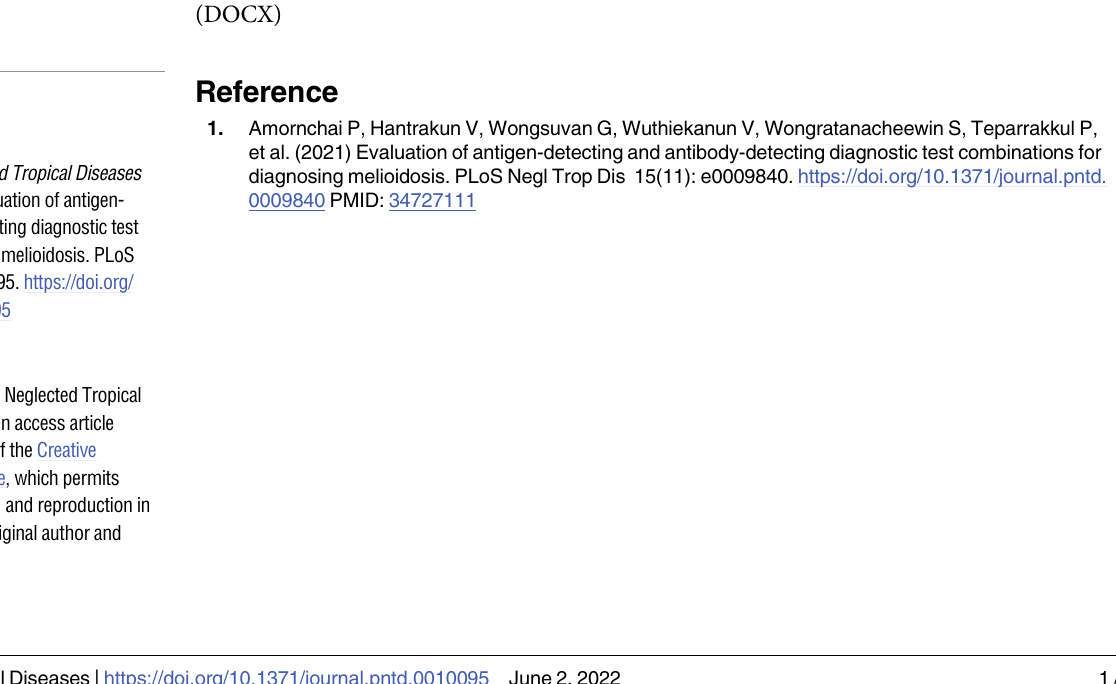
S2 Table. Sensitivity and specificity of a combination between CPS-LFI and Hcp1-ELISA and a combination of CPS-LFI and OPS-ELISA using different OD cut-off values. This table includes supplementary data. S3 Table. Diagnostic test results in different groups of melioidosis case patients. This table includes supplementary data. S4 Table. Diagnostic test results in different groups of control patients. This table includes supplementary